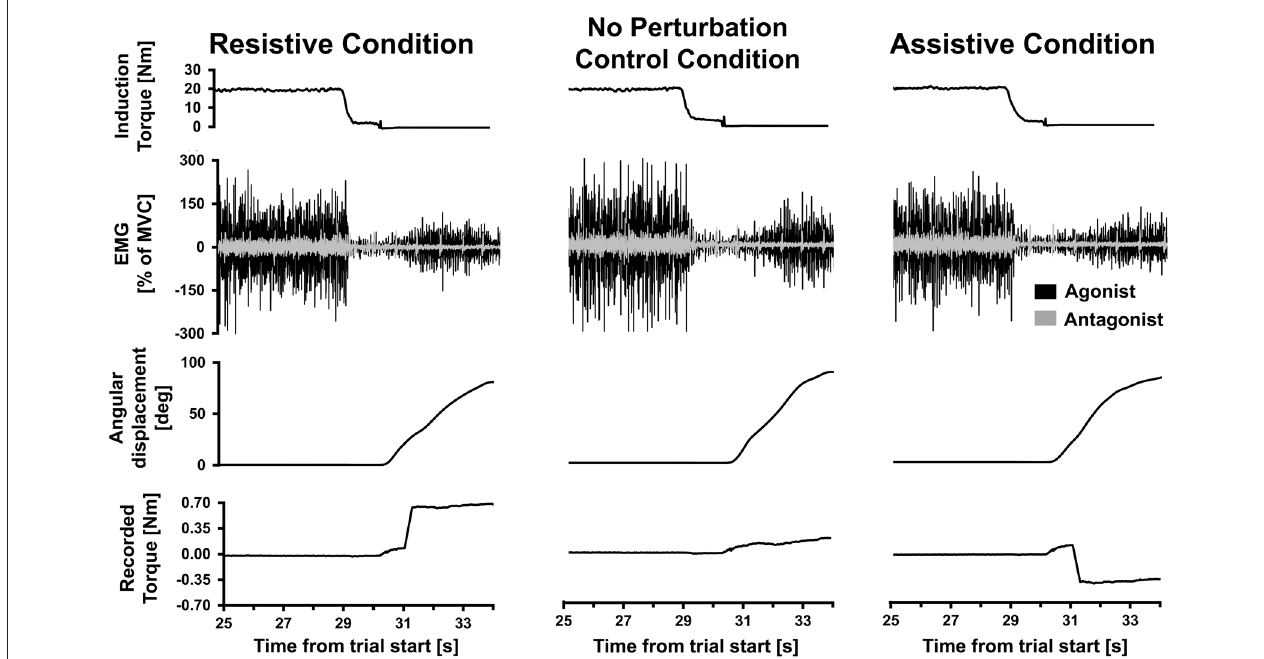
FIGURE 2 | Single trial data. Data from three Kohnstamm movement trials from a single representative participant, belonging to the Resistive perturbation, No perturbation control and Assistive perturbation conditions. Last 5 s of the 30 s isometric induction contraction is shown, followed by a brief latent period of ∼ 1 s and then the aftercontraction. Note that induction torque was equivalent across trials. During aftercontraction agonist (posterior deltoid) electromyography (EMG) increased in amplitude as angular displacement of the shoulder increased. Antagonist (pectoralis) EMG was flat throughout the aftercontraction (regular spikes shown were from heart beat artifact). In the Resistive perturbation condition trial, a torque was applied in the opposite direction to the movement once angular displacement reached 20 ◦ (0.5 Nm; 250 ms linear ramp). In the Assistive perturbation condition trial, a torque was applied in the same direction as the movement once angular displacement reached 20 ◦ (0.5 Nm; 250 ms linear ramp). The lower traces show the torque recorded at the shoulder manipulandum: note the abrupt changes in torque due to the